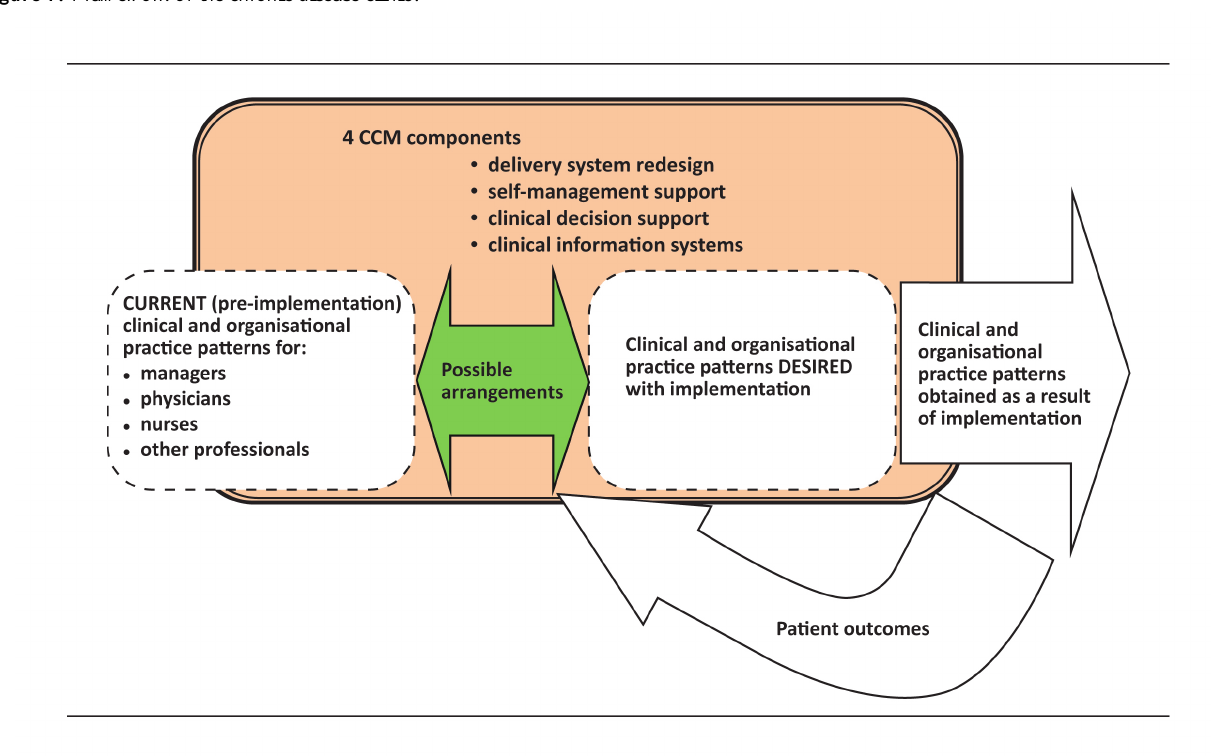
Figure 1. Framework of the chronic disease